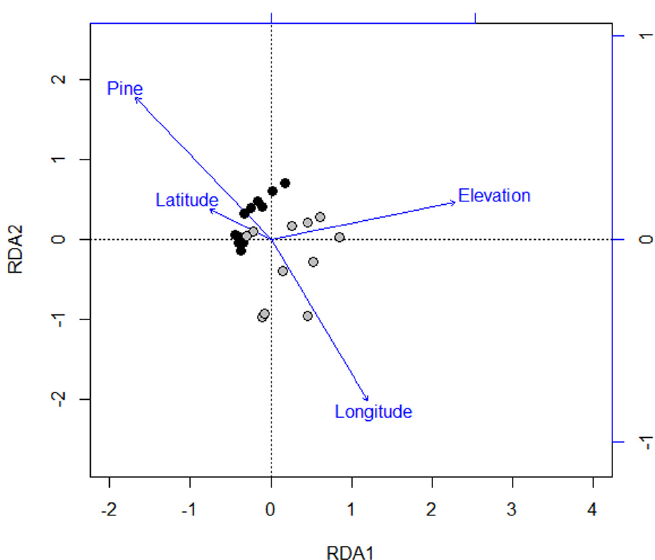
Figure 3. A RDA ordination of species composition of ground beetles in 22 sites. The first and second RDA axes are shown. The different forest types are shown as closed circles by different colors, i.e., black, broad-leaved deciduous forests and grey, Pinus densiflora forests. Table 3. Correlations between environmental variables or species richness and the axes in the RDA analyses (total inertia = 0.3808). Species richness was calculated by biological or ecological groups.